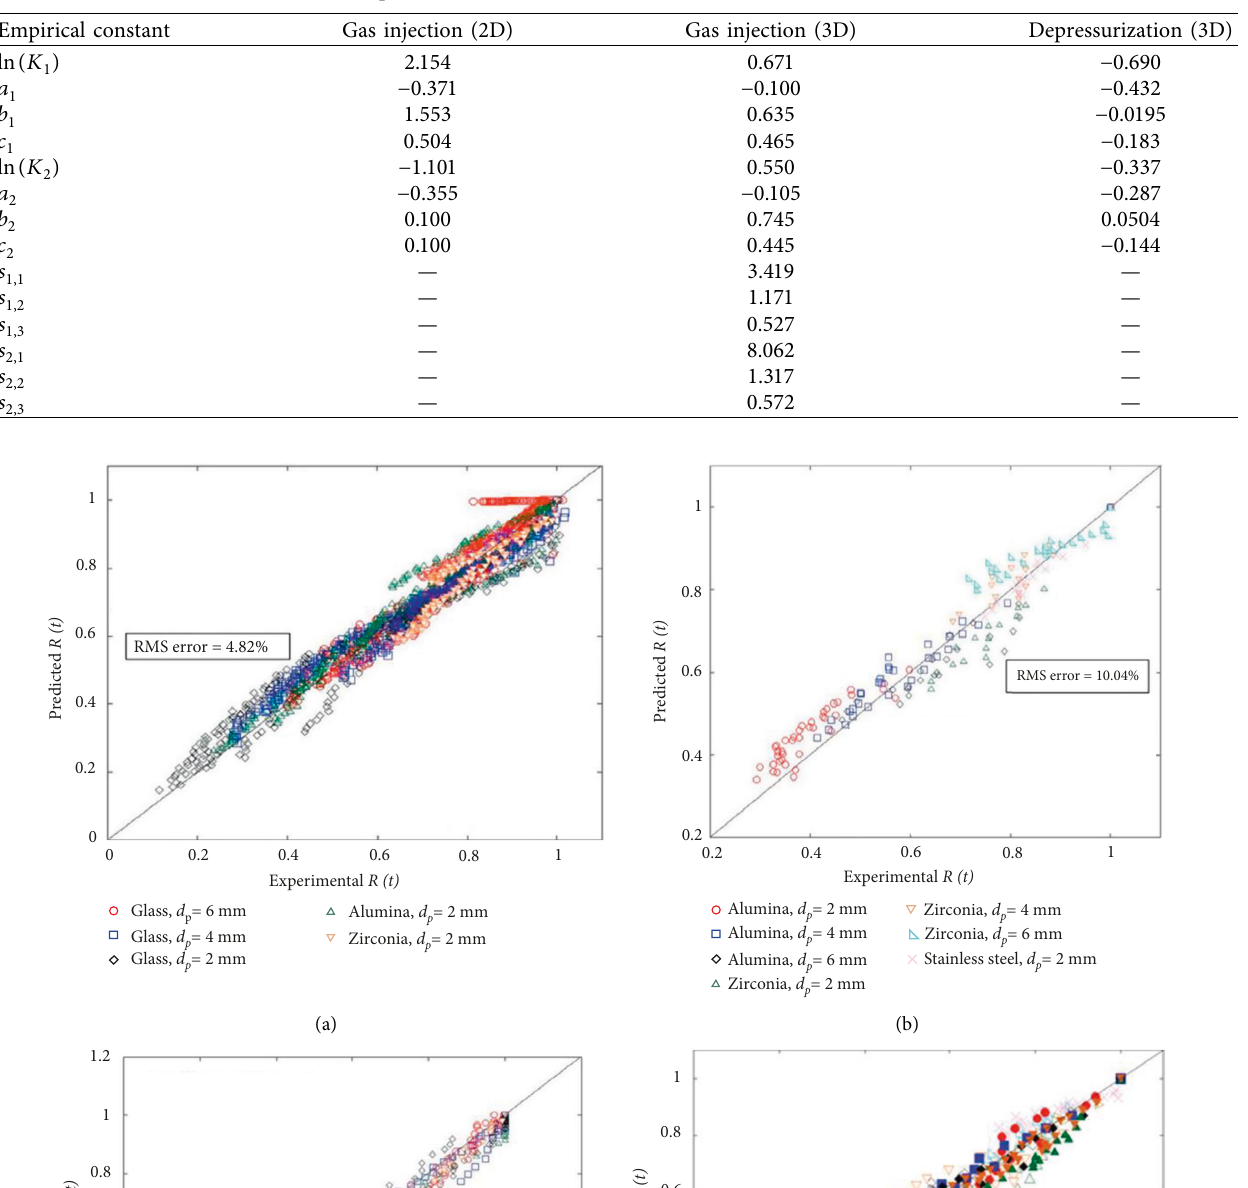
Table 2: Empirical constants determined for the model of R ( t ) [33, 34,